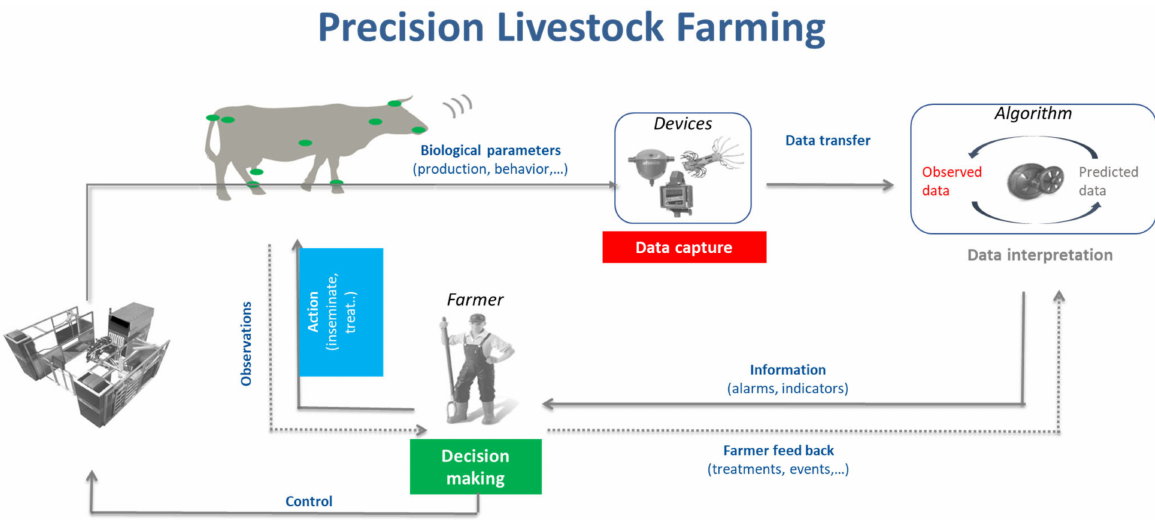
Figure 1. Overview of a PLF system of various components on a dairy farm. The automated milking system (AMS) in this case serves as a complex of sensors capturing data from an individual animal. The attached algorithm interprets the data and creates predictions that are transmitted to the farmer to aid decision making